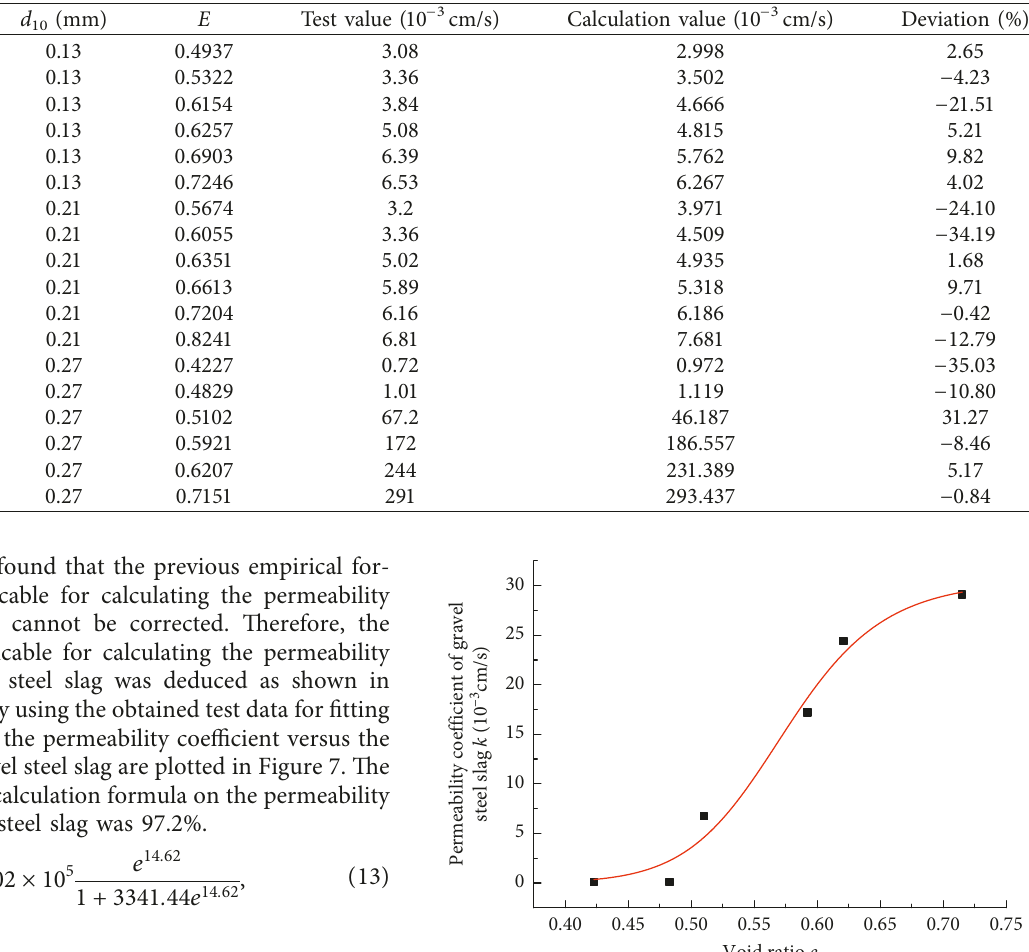
Table 8: Comparison between test values and formula calculation values on the permeability coefficient of fine steel slag and coarse steel slag.